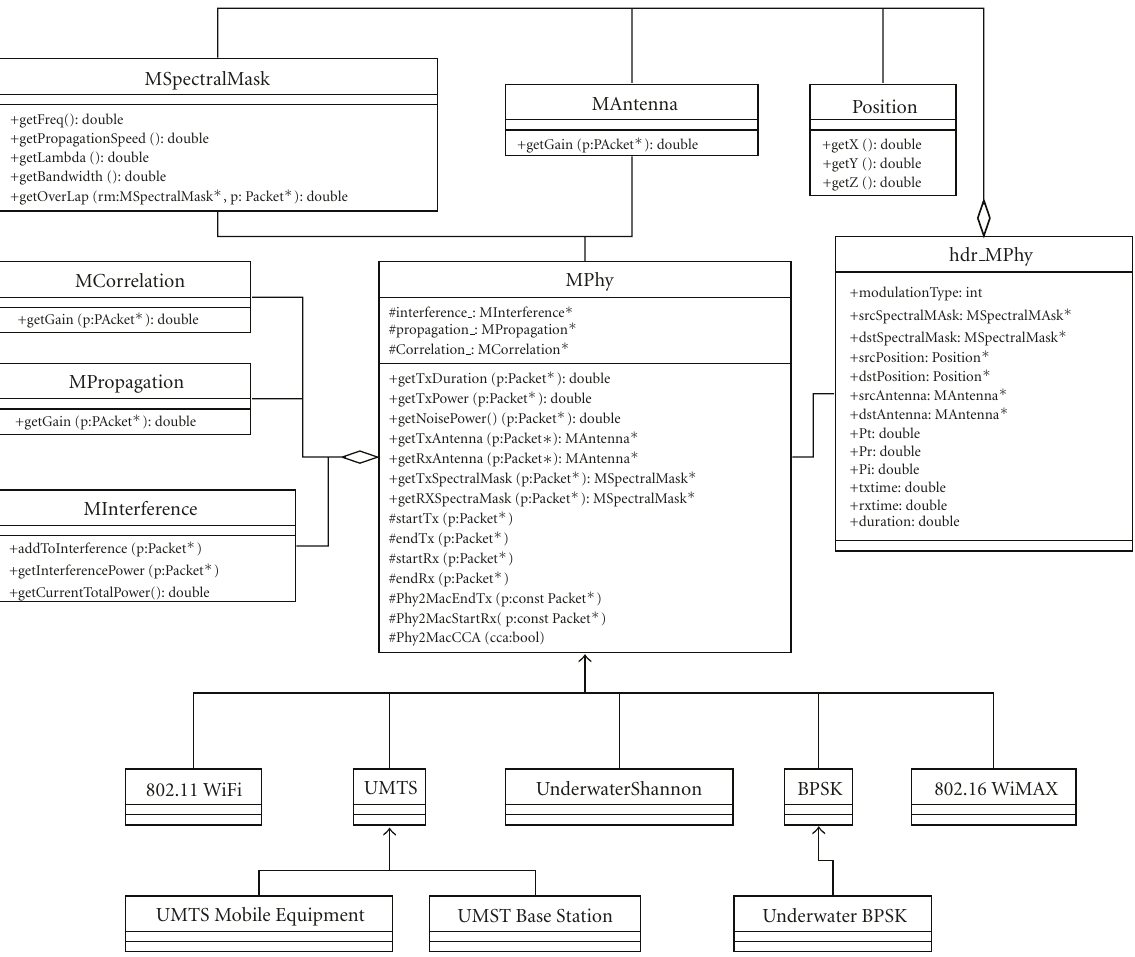
Figure 3: Class diagram for MPhy and related